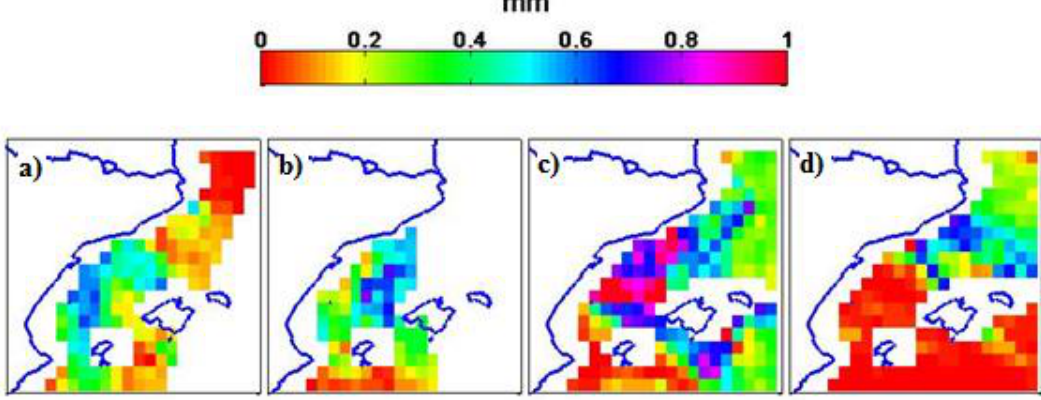
Fig. 11. Columnar cloud liquid water measured by AMSR-E during the episode, each image corresponding to passes at: (a) 02:24 UTC 9 May, (b) 13:36 UTC 9 May, (c) 01:30 UTC 10 May, and (d) 12:42 UTC 10 May (source: http://www.remss.com/). Figure 11. Columnar cloud liquid water measured by AMSR-E during the episode, each 3 overestimating heavily at the central and southern image corresponding to passes at: a) 02:24UTC 9 May, b) 13:36UTC 9 May, c) 4 01:30UTC 10 May, and d) 12:42UTC 10 May (source: http://www.remss.com/). 5